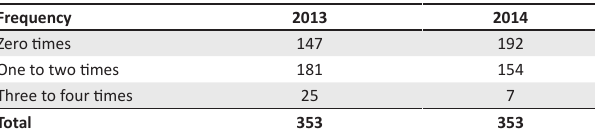
TABLE 2: Frequency of enterprises being affected by flooding between 2013 and